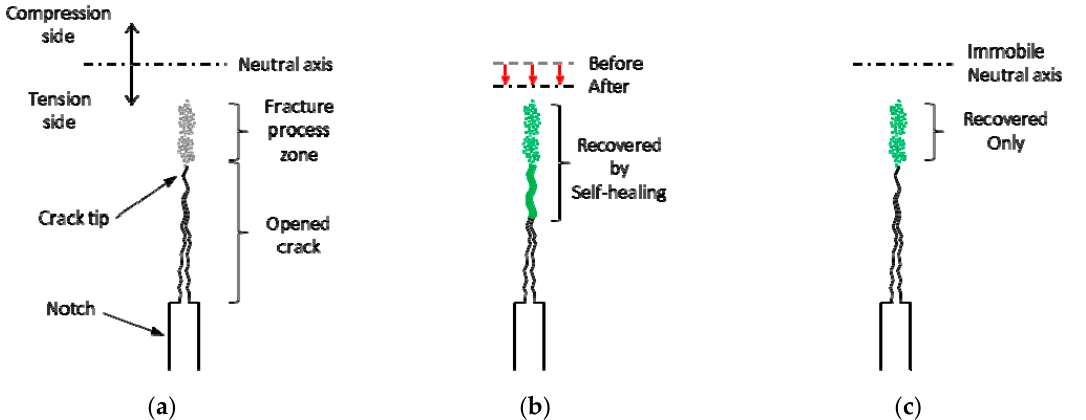
Figure 20. Schematic of neutral axis movement before and after healing. ( a ) Unloaded state; ( b ) assumed